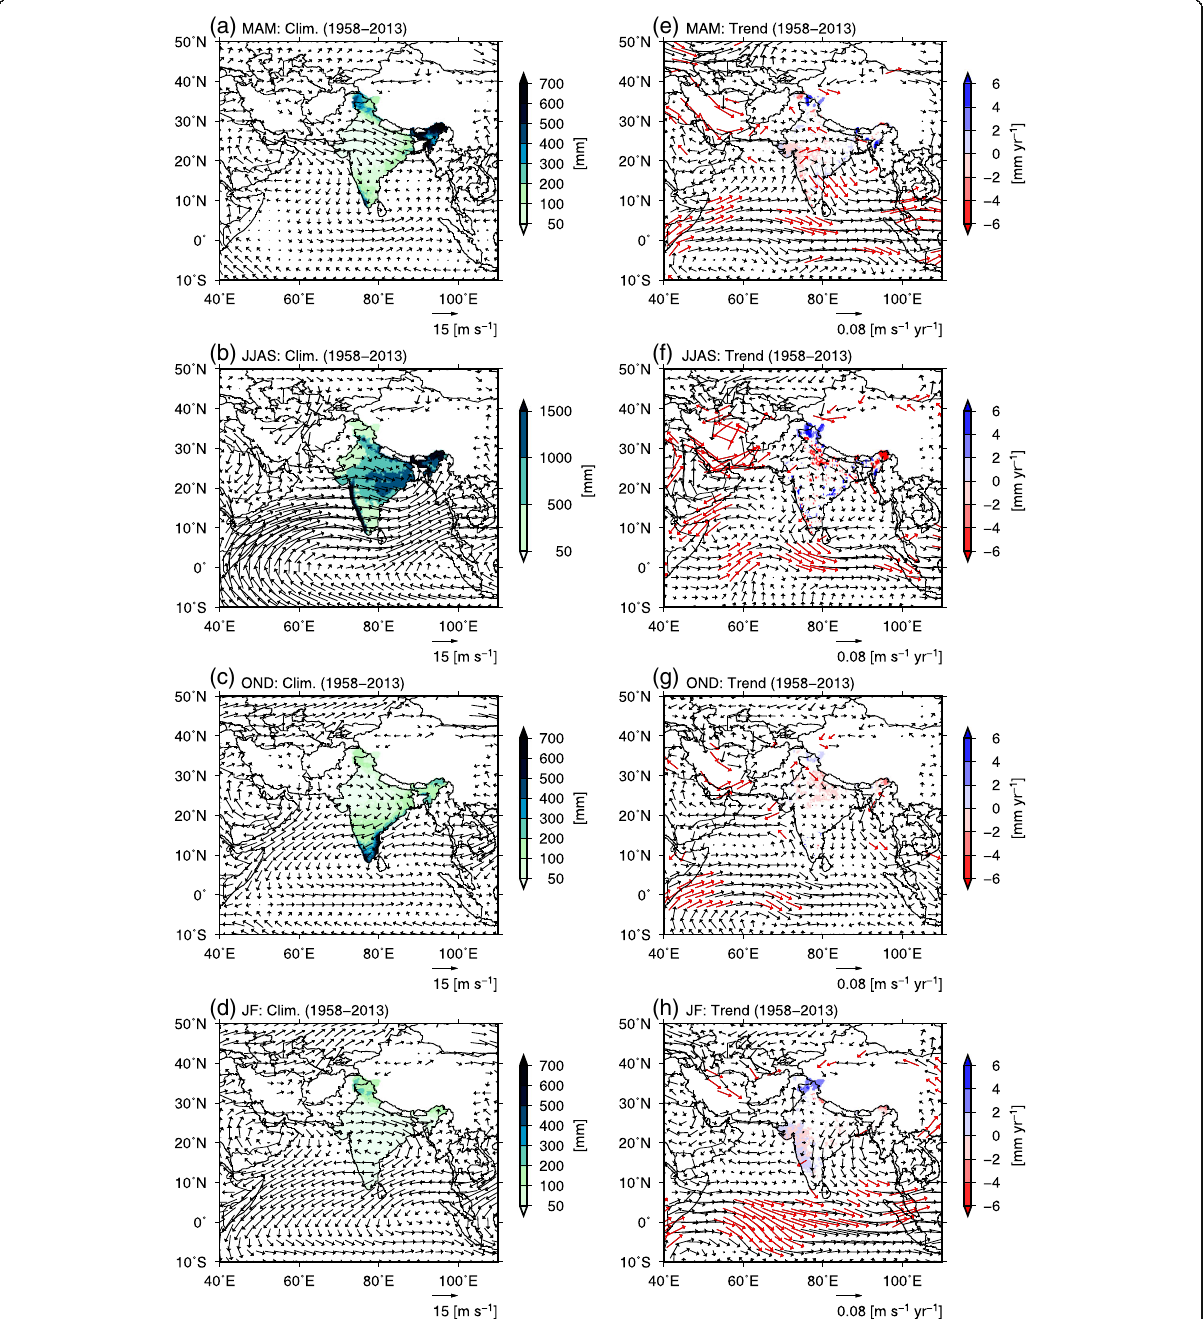
Fig. 6 Distribution of the climatological value averaged for 1958 – 2013 for seasonal precipitation and wind vectors at 850 hPa and long-term variation of the wind field at 850 hPa during 1958 – 2013. Precipitation (mm season − 1 ) (shaded) and wind vectors at 850 hPa (m s − 1 ) (vector) for MAM ( a ), JJAS ( b ), OND ( c ), and JF ( d ). Slope of the liner trend (mm season − 1 year − 1 ) at the 5% significance level based on the Mann – Kendall test (shaded) and the regression coefficient of secular variation of wind at 850 hPa (vector) in MAM ( e ). Same as ( e ) but for JJAS ( f ), same as ( e ) but for OND ( g ), and same as ( e ) but for JF ( h ). Colored (red) vector shows significance over the 2% level based on the Student t